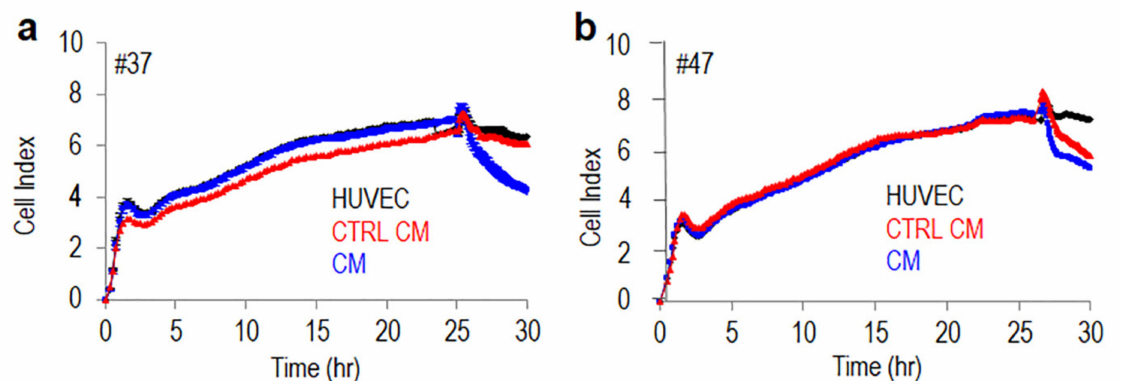
Figure 7. Monocytes pre-exposed to MPLS cells increases trans-endothelial migration of primary MLPS cells. HUVECs (1 × 10 4 cells/well) suspended in growth medium were seeded onto E-plates and allow to grow for 25 h until they form a confluent monolayer. Then, primary #37 ( a ) and #47 ( b ) MLPS (2 × 10 3 cells/well) suspended in CM from human monocytes pre-co-cultured with of MLPS cells, or control monocytes (CTRL CM) were seeded onto endothelial monolayers with serum added to a 10% final concentration. Cell index changes due to crossing of the endothelial monolayer were monitored in real-time for 5 h. The experiments were performed twice in